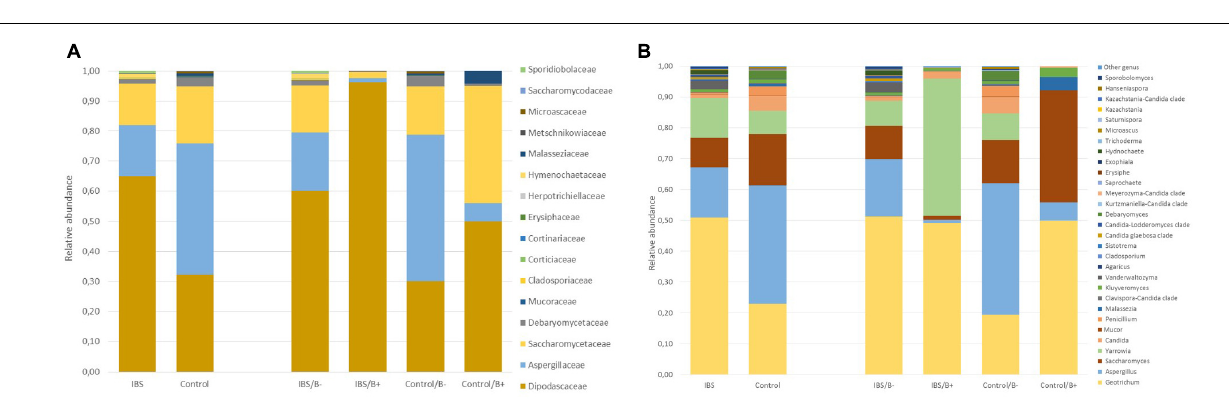
FIGURE 6 | Comparison of alpha diversity indices of the fecal fungal microbiota between controls (E–H) and IBS-C subjects (A–D) according to Blastocystis carriage. (A,E) Chao 1, (B,F) observed number of OTUs, (C,G) Shannon diversity, and (D,H) Simpson’s index. Significant (or close to significance) p -values were reported on boxplots. IBS/B-: Blastocystis -negative IBS patients; IBS/B + : Blastocystis -positive IBS patients; Control/B-: Blastocystis -negative control subjects; Control/B + : Blastocystis -positive control subjects.